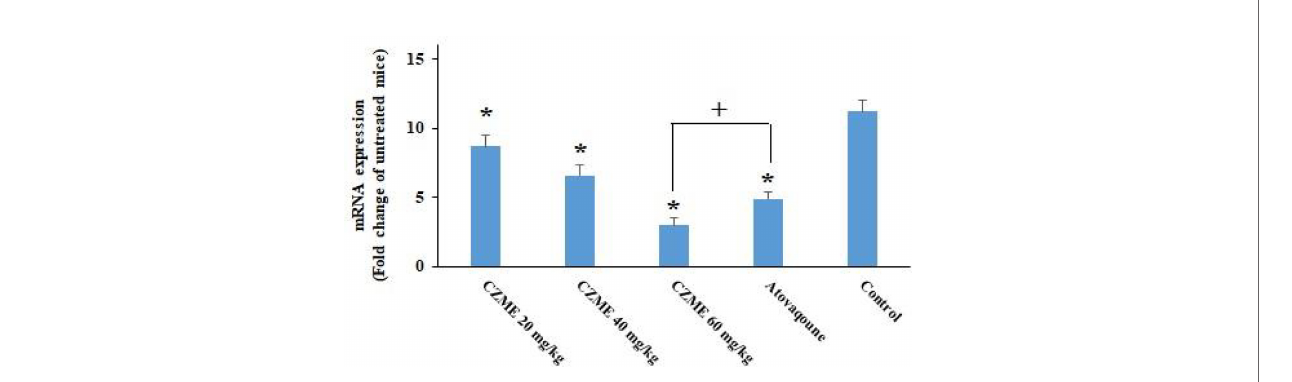
FIGURE 5 | The effects of C. zeylanicum methanolic extract (CZME) on the expression level of bradyzoite surface antigen 1 (BAG1) in infected mice. But treatment of infected mice with CZME results in a signi fi cant (p < 0.001) downregulation of BAG1 in a dose-dependent response (p < 0.05). Mean ± SD. *p < 0.001 compared with the control group; +p < 0.05 compared with atovaqoune.